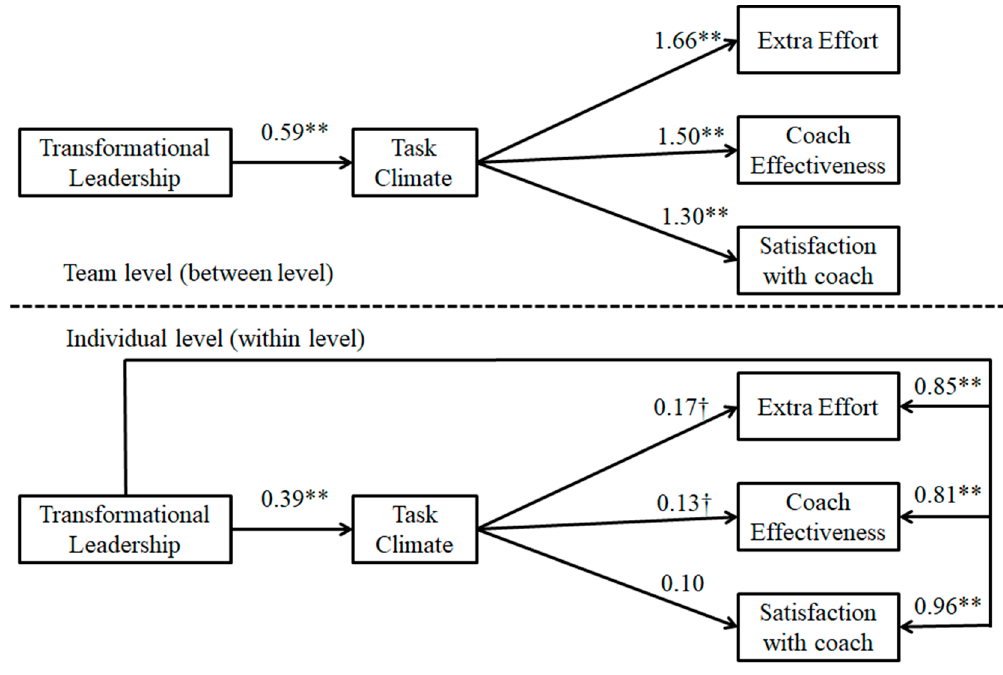
Figure 2. Unstandardized solution for the revised (M2) mediation multilevel SEM of the associations between transformational leadership style, task-involving climate, and outcome criteria. † p < 0.10; ** p < 0.01.